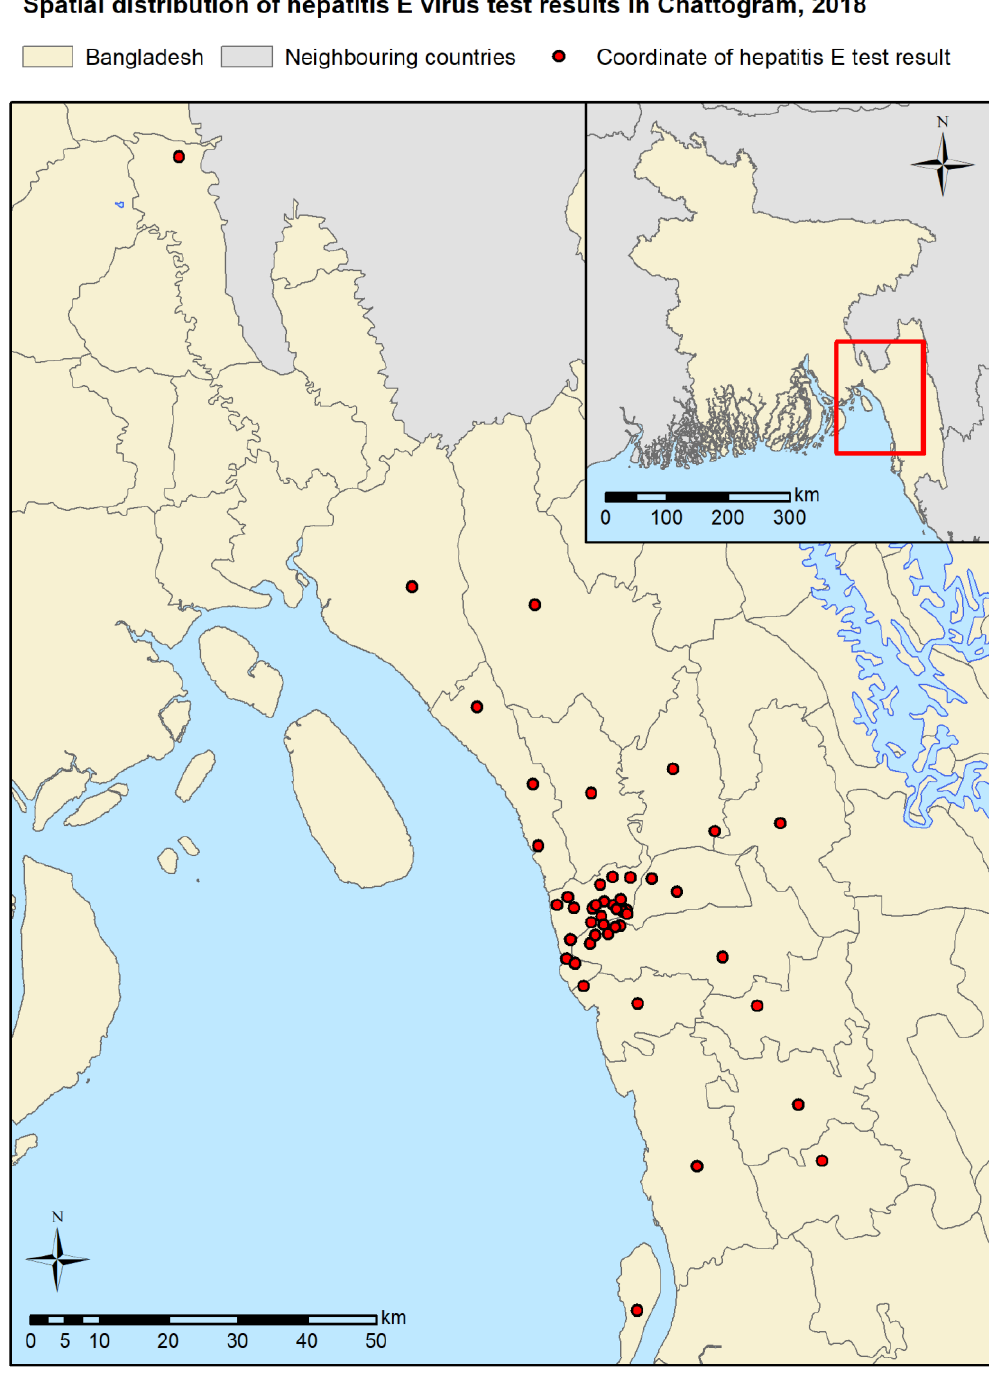
Figure 1. Map of spatial distribution of hepatitis E virus (HEV) test results in study area. Some coordinates contain multiple test results.